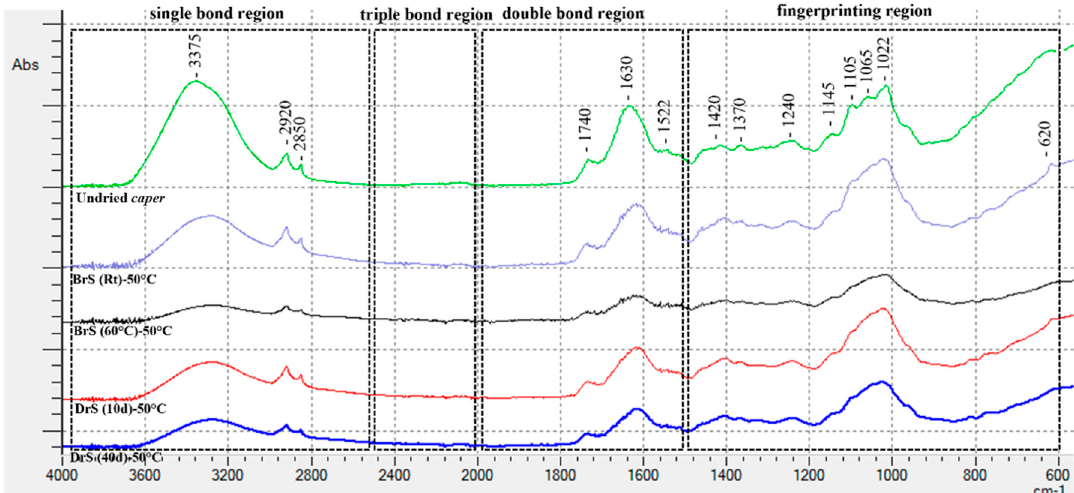
Figure 3. ATR-FTIR spectra of caper powders obtained from the different trials.